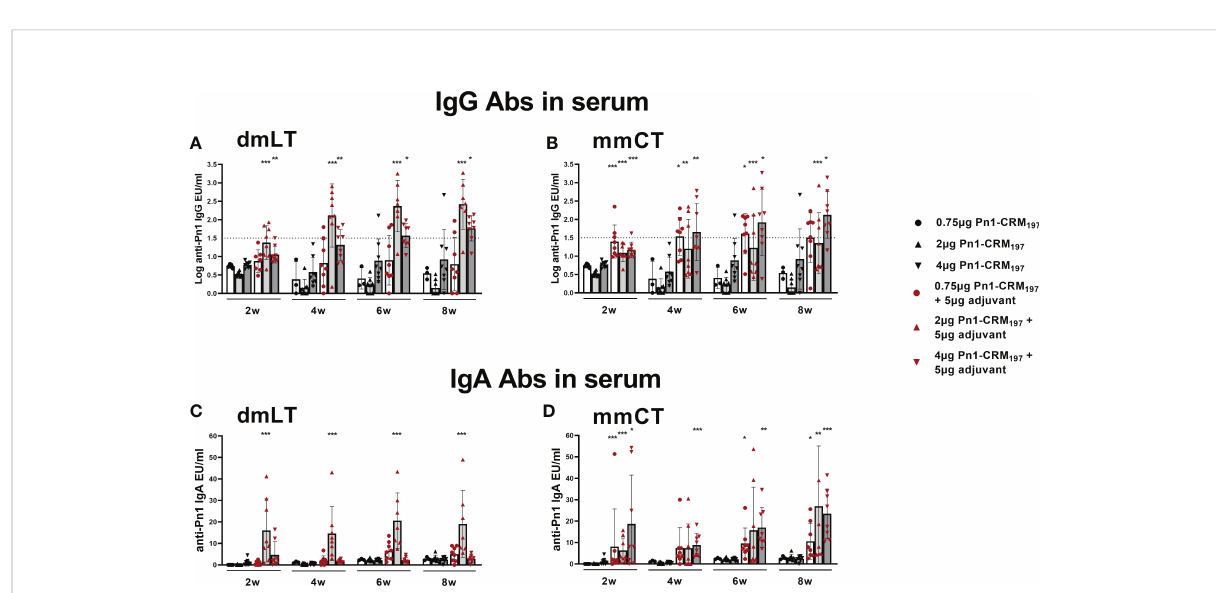
FIGURE 5 Increasing vaccine dosage via i.n. route enhances IgG Abs above protective levels for bacteremia. IgG (A, B) and IgA (C, D) Abs in serum 2, 4, 6 and 8 weeks after immunization of neonatal mice with different doses (0.75 µg, 2 µg, 4 µg) of Pn1-CRM 197 alone s.c. or i.n. with dmLT or mmCT with comparable doses. Results are expressed as IgG levels (log mean EU/ml ± SD) or IgA levels (mean EU/ml ± SD) in 6 – 8 mice per group and statistical difference was calculated using Mann – Whitney U-test where adjuvant groups were compared to vaccine only group with the same dose of antigen. *p < 0.05, **p < 0.01, ***p < 0.001. The dotted line representes protective IgG Ab levels for pneumococcal